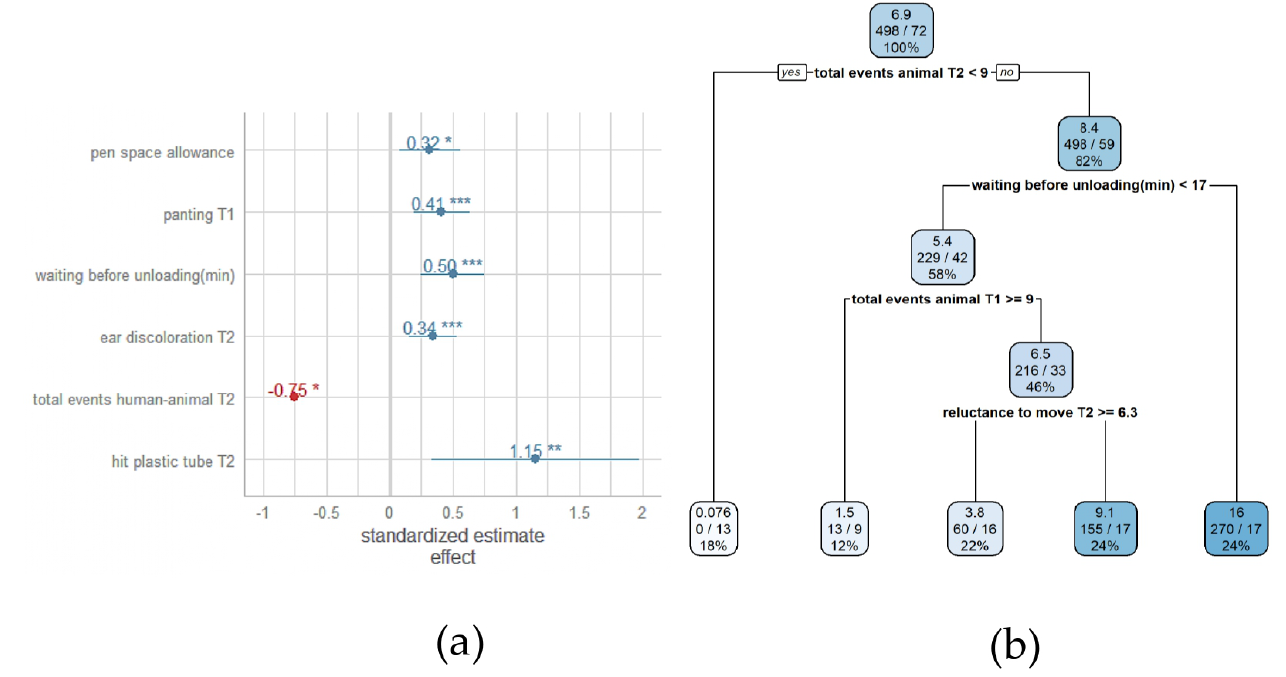
Figure 2. Association between pre-slaughter conditions and severe lesions in the rear region of heavy pig carcasses: ( a ) forest plot and ( b ) regression tree plot. In forest plot ( a ), * stands for p < 0.05, ** for p < 0.01, and *** for p <